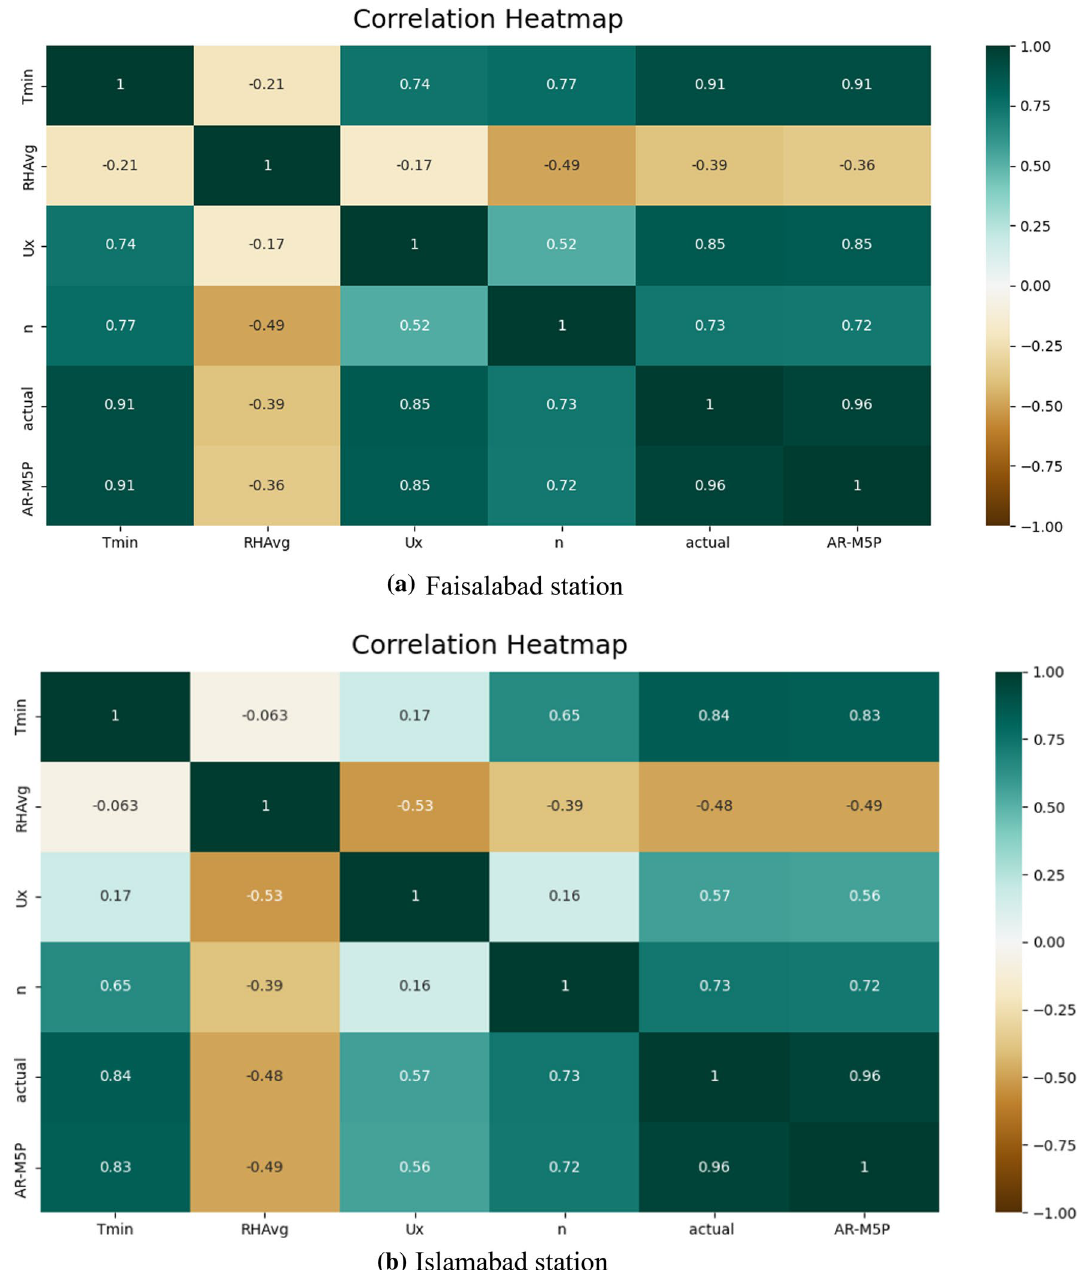
Fig. 10 Pearson’s correlation matrix and heat maps between explanatory and response